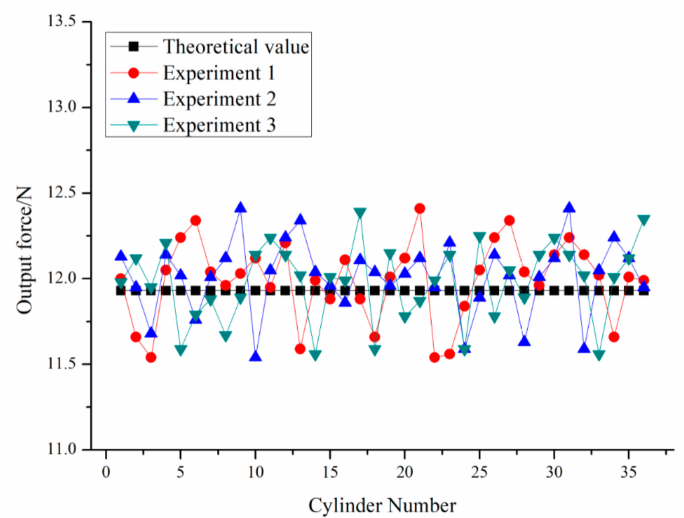
Figure 18. Force output consistency